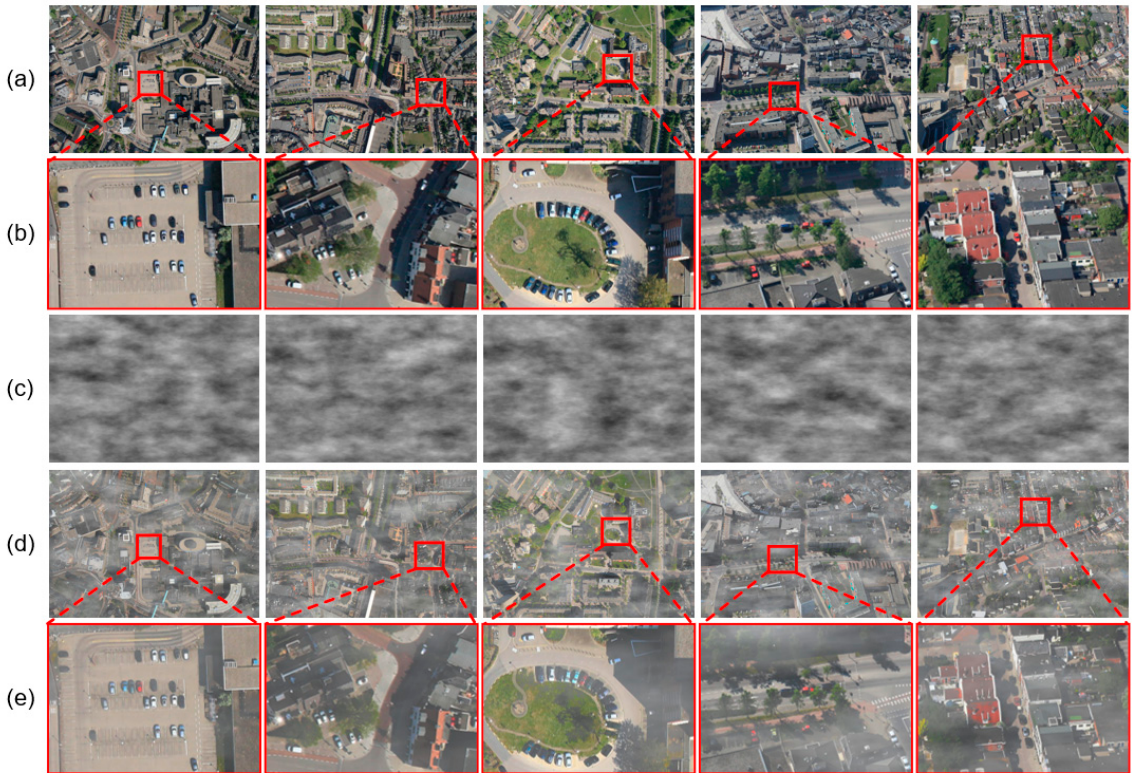
Figure 11. Data augmentation. (ITCVD dataset) ( a ) optical image; ( b ) partial enlarged view; ( c ) cloud layer simulated; ( d ) simulated images with clouds; ( e ) partial enlarged view of simulated image.